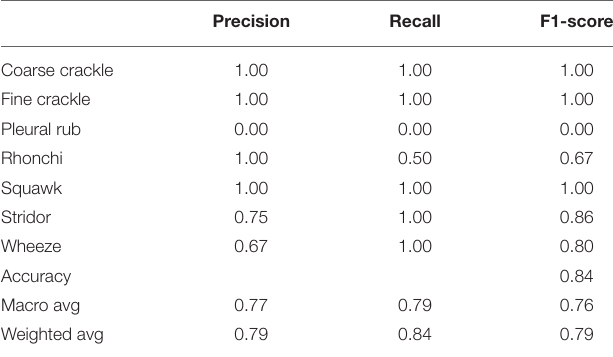
TABLE 4 | Comparative results obtained (Precision and Recall) for VGG-V2. Precision